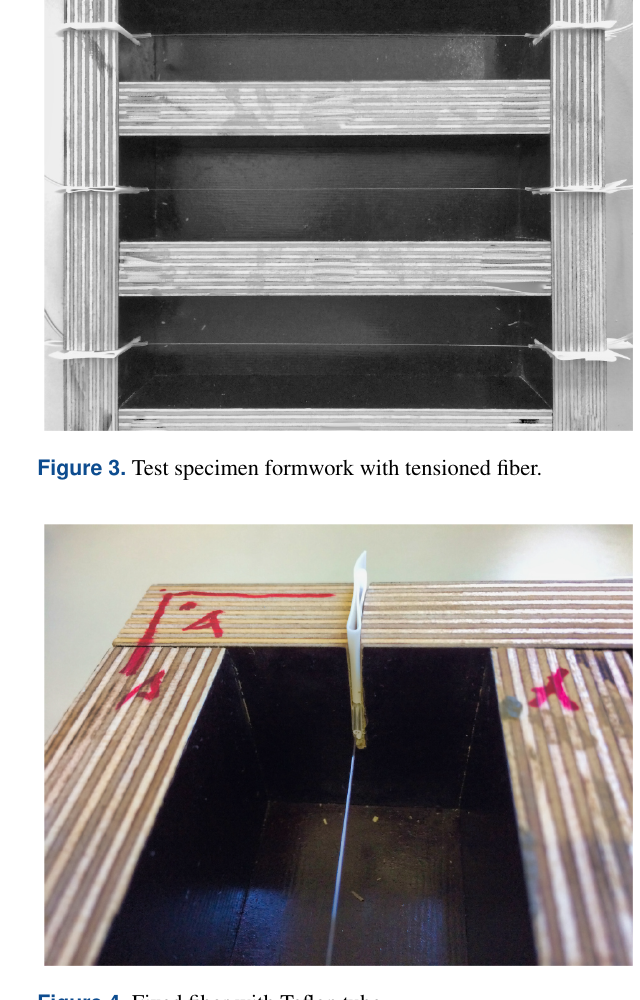
Figure 4. Fixed fiber with Teflon tube.